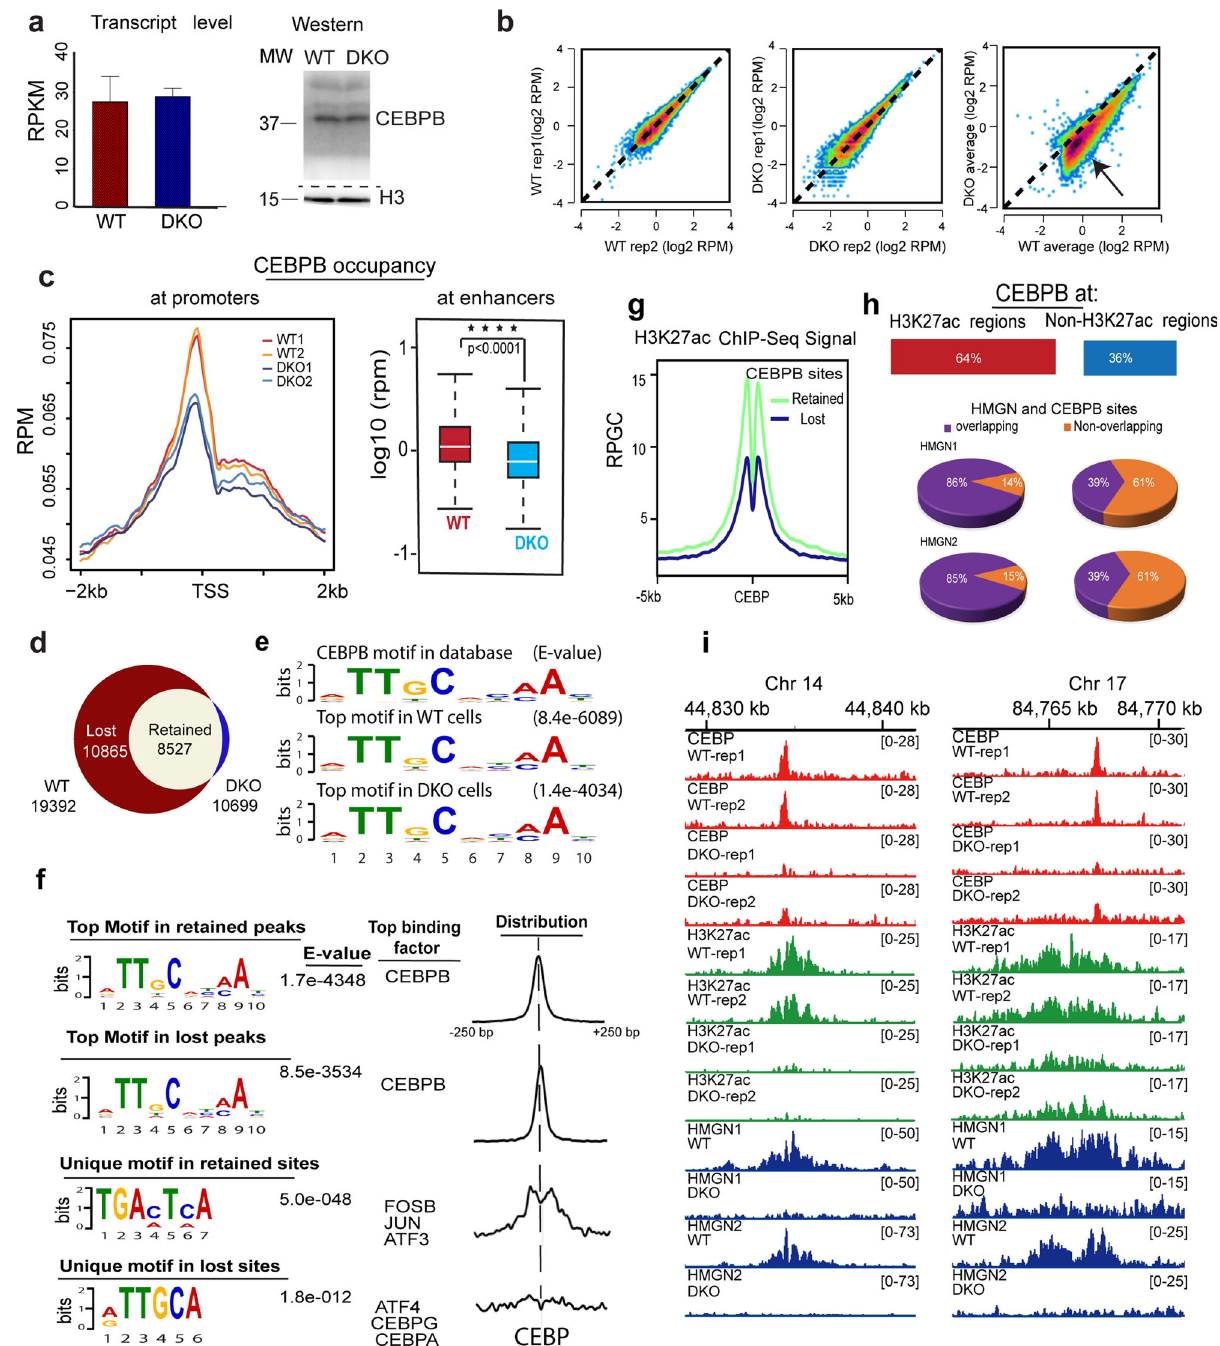
Fig. 5 Decreased CEBPB chromatin binding in DKO MEFs. a Equal levels of CEBPB transcript and protein in WT and DKO MEFs . b Scatter plot comparing intensities of CEBPB peaks between biological replicates of WT (left), and of DKO cells (center). Right scatter plot shows reduced CEBPB chromatin binding in DKO cells. c Decreased CEBPB binding at TSS and enhancers of DKO cells. d Venn diagram showing CEBPB chromatin binding sites in WT and DKO MEFs. e Top DNA sequence motif underlying the CEBPB binding sites in WT and DKO cells, compared with the CEBPB motif in database. f Top and unique motifs in retained and lost CEBPB binding sites. Lost CEBP sites are de fi ned as present in WT but not in DKO cells. The diagrams to the right show the location of the DNA binding motifs relative to the center of the CEBPB binding motif. g H3K27ac levels at lost or retained CEBPB sites in WT cells. h Overlap between CEBPB, H3K27ac and HMGN occupancy. i IGV snapshots showing loss of CEBPB binding in DKO cells at regions overlapping with H3K27ac. All ChIP analyses from two biological